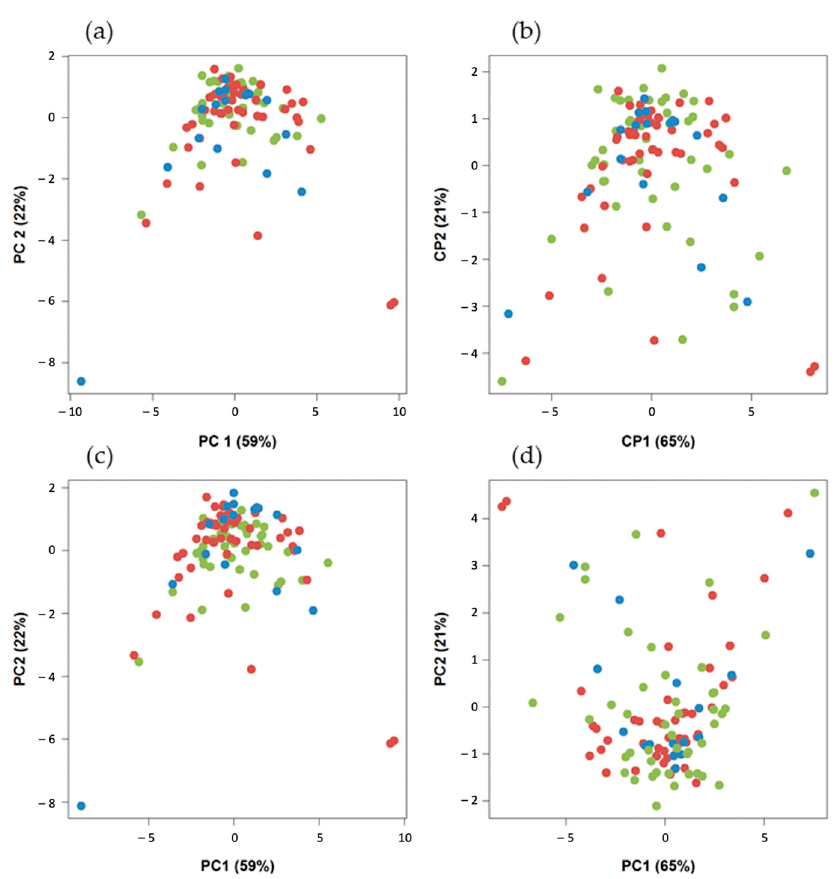
Figure 5. Projection of the three types of PET/CT system in the first PCA plane (Discovery 690, n = 49 (red); Discovery IQ 5 rings, n = 17 (blue); and Discovery ST, n = 45 (green)): ( a ) without harmonization, ( b ) with ComBat harmonization, ( c ) with batch-effect removal harmonization and ( d ) variable standardization harmonization.